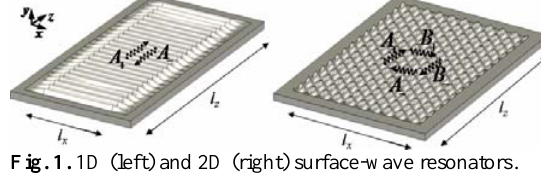
Fig. 1. 1D (left) and 2D (right) surface-wave resonators.